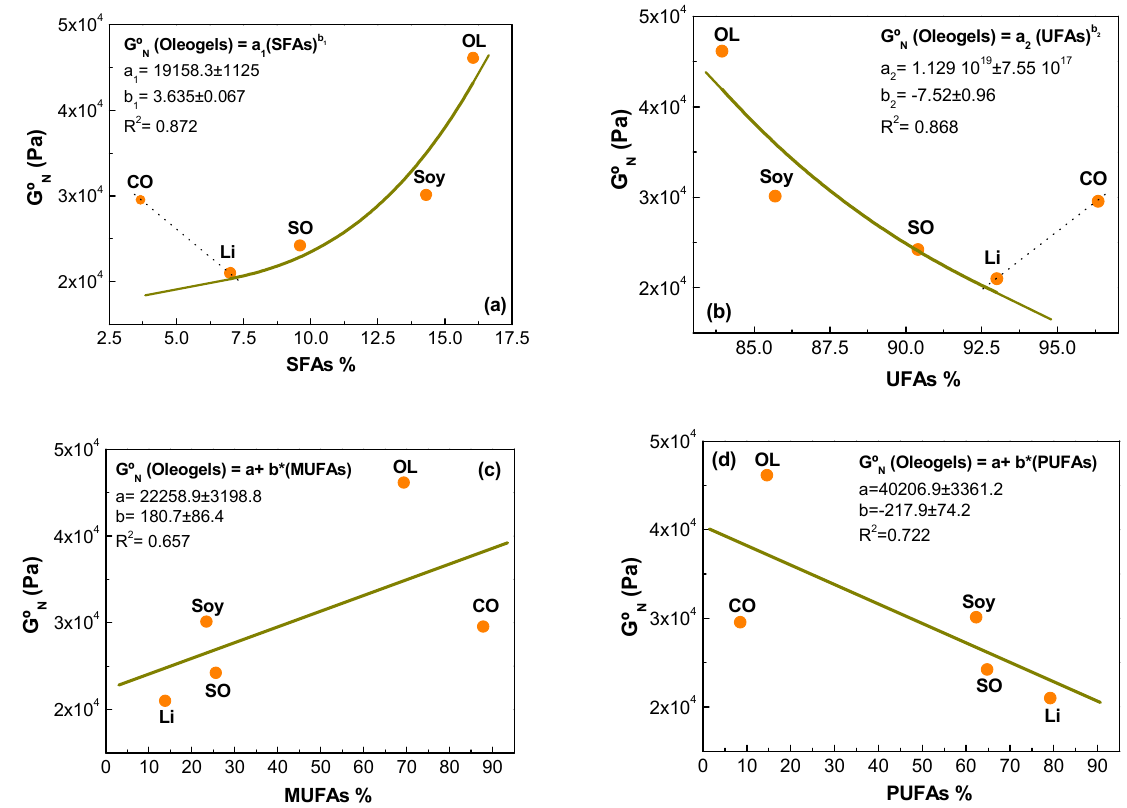
Figure 3. Evolution of plateau modulus of oleogels as a function of: ( a ) Saturated fatty acids (SFAs); ( b ) Unsaturated fatty acids (UFAs); ( c ) Mono-unsaturated fatty acids (MUFAs); ( d ) Poly-unsaturated fatty acids (PUFAs).